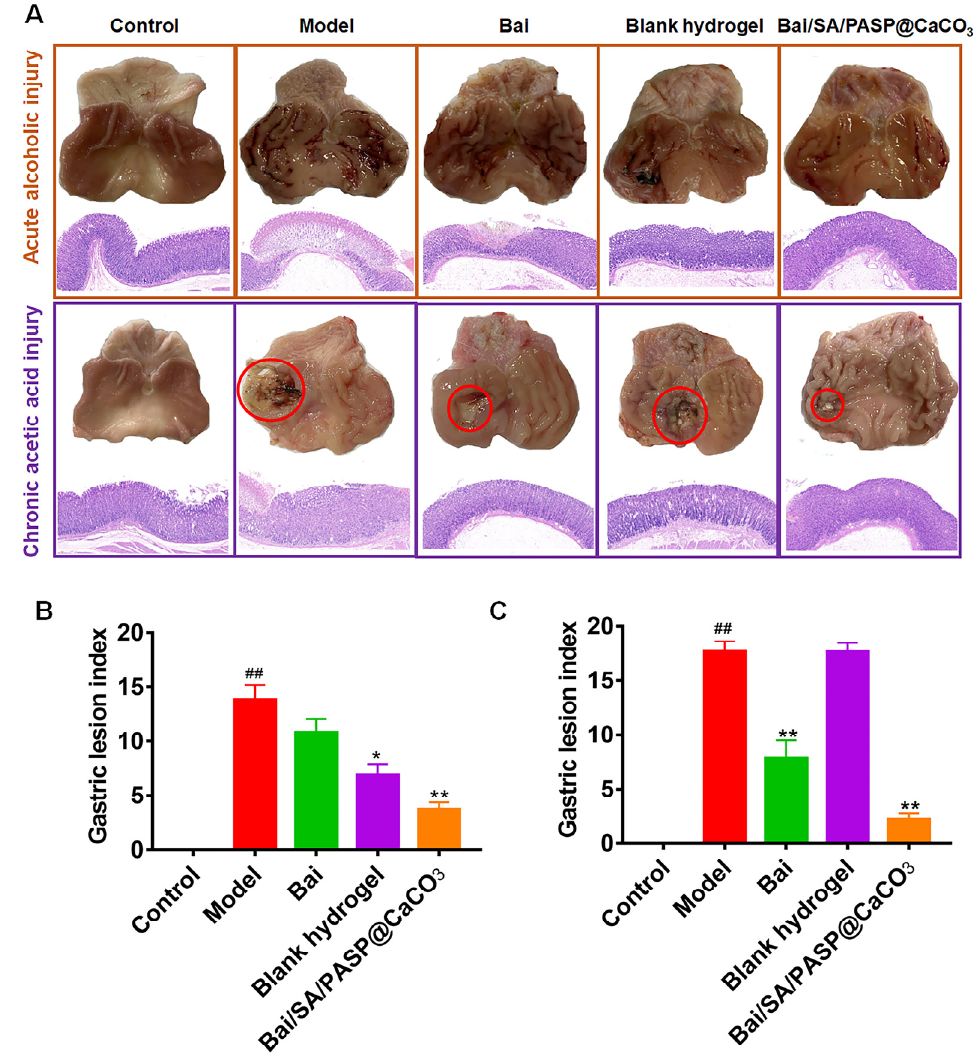
Figure 6. ( A ) Representative macroscopic images and histological assessment of the gastric tissue in ethanol-induced acute injury and acetic acid-induced chronic injury. Red circles represent the ulcers. Gastric lesion indexes of acute alcoholic injury ( B ) and chronic acetic acid injury ( C ). ## p < 0.01 vs. the control group, and * p < 0.05 and ** p < 0.01 vs. the model group.